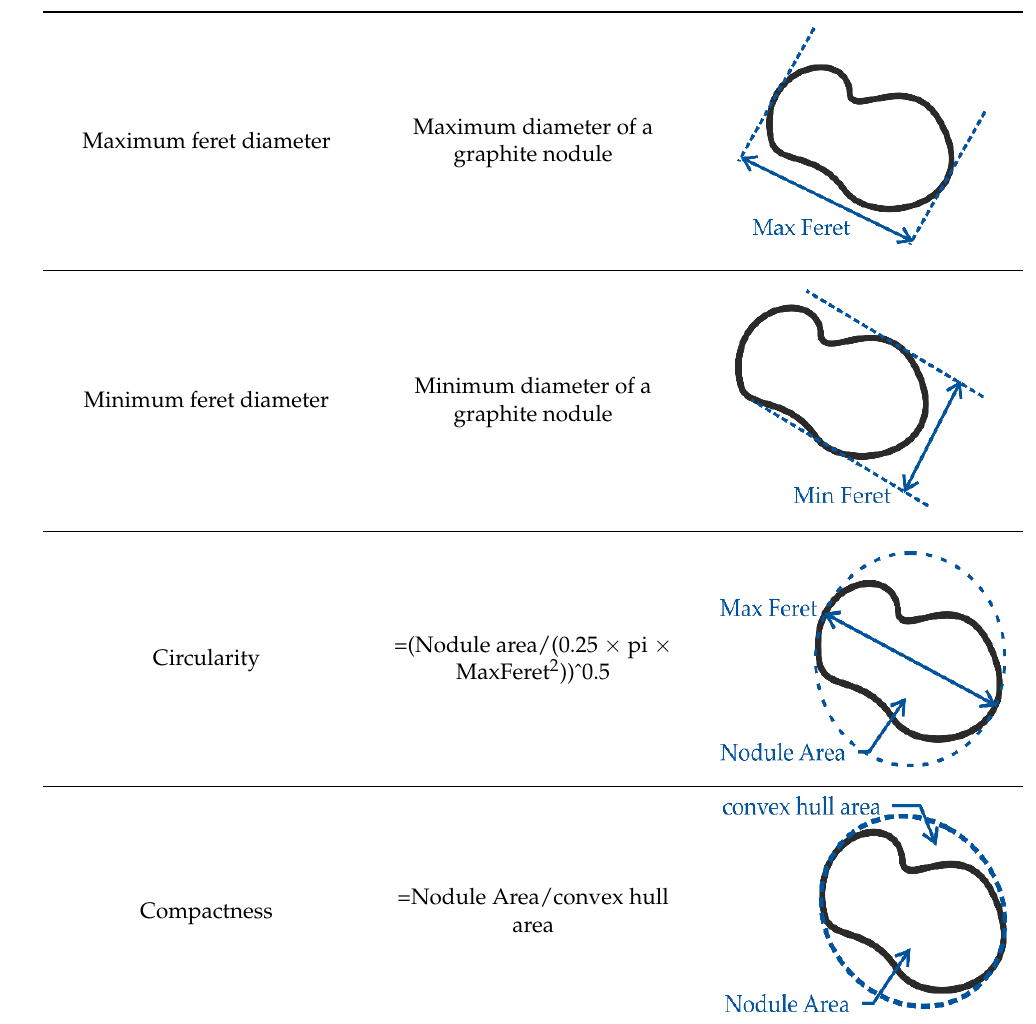
Table 2. Parameters for the quantitative description of graphite morphology.